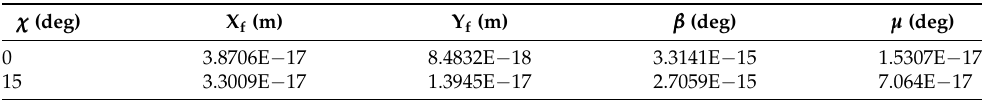
Table 4. Calculation of the RMSE between the cross-product and surface parametrized models for comparing the two